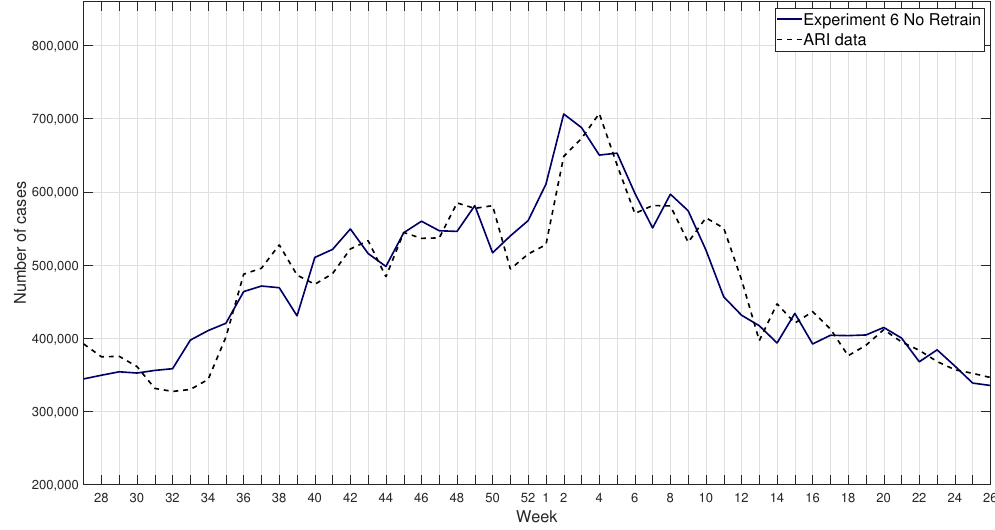
Figure 6. ARI data and FFNN response forecasting one week in advance for the 2017–2018 winter season.